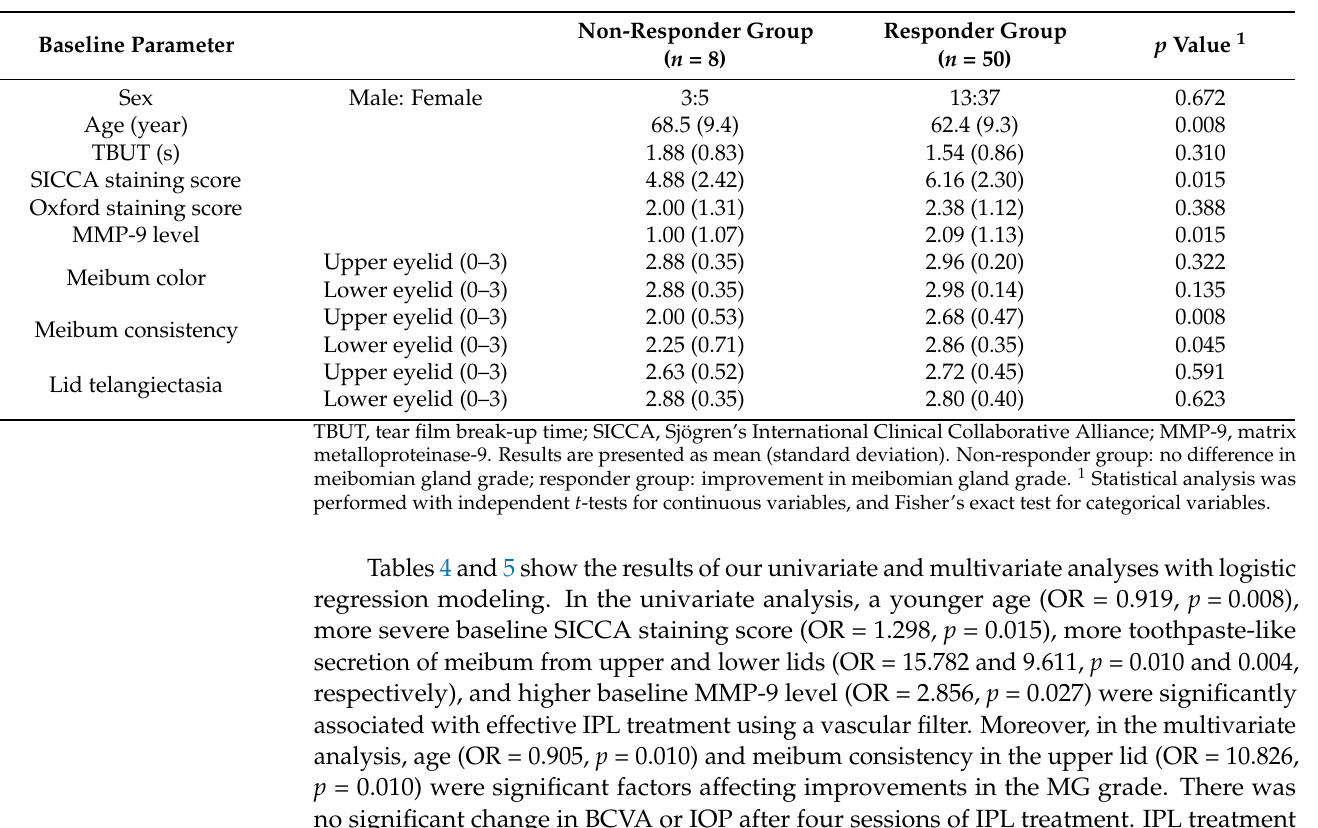
Table 3. Differences in baseline clinical parameters between the non-responder and responder